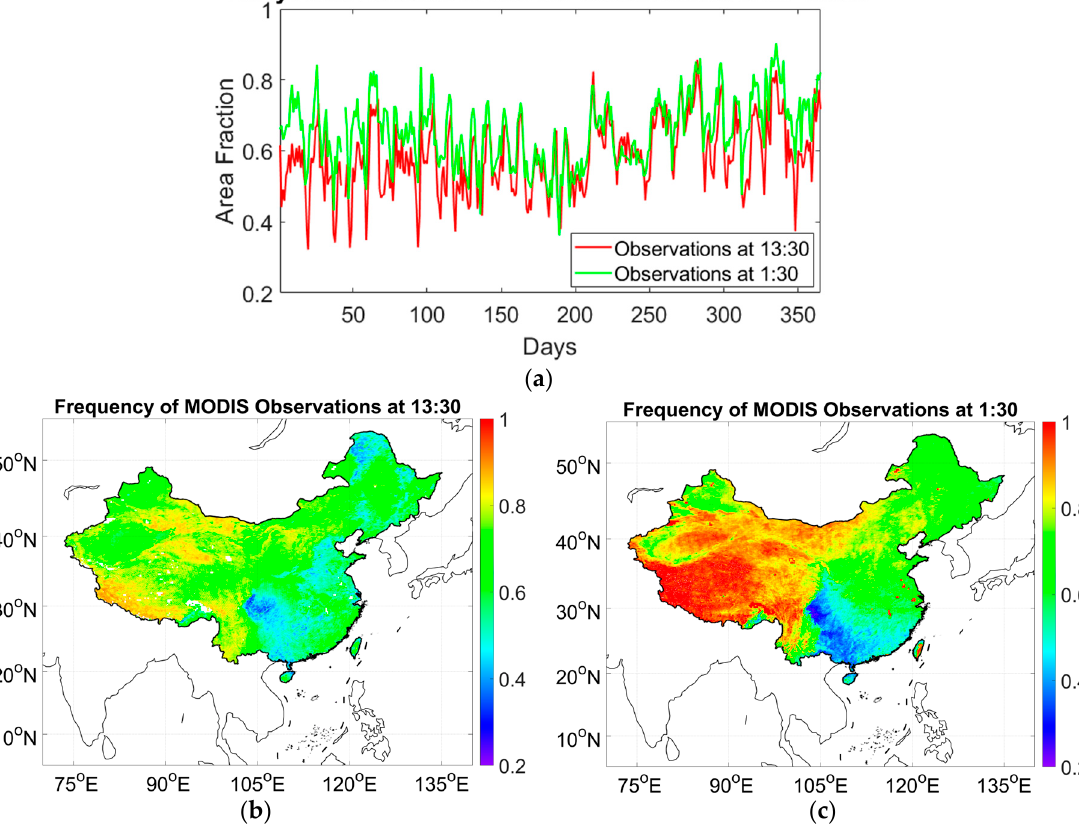
Figure 4. Coverage of MODIS observations over China in 2013 ( a ) and frequency of valid MODIS observations for each pixel at 13:30 ( b ) and 1:30 ( c ) in 2013.